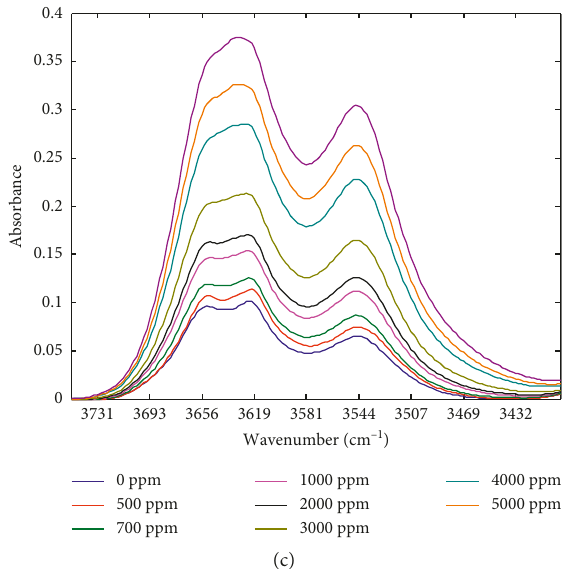
Figure 4: Spectra of acetonitrile with moisture extracted from transformer oil.